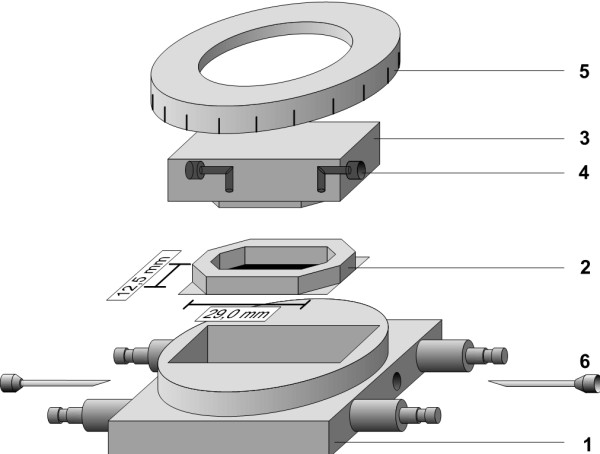
Parallel plate flow chamber. The flow chamber consisted of a heatable metal case (1). The silicone-sealed coverslips (2) were placed in the middle. Using a transparent cover block (3) with a flow channel (4) and a scaled metal ring (5), the chamber could be closed to a defined height leaving an inner chamber with a defined height of 0.2 mm. The tubing of the cell suspension was connected by a needle (6) to the inlet and outlet port of the transparent cover block (4). Temperature was controlled by temperature measurement within the metal case. Preliminary experiments showed that temperature of the metal block equaled with temperature of the perfusate within few seconds. For microscopy of the adhesion assay, the whole system was placed on an inverted phase-contrast microscope.